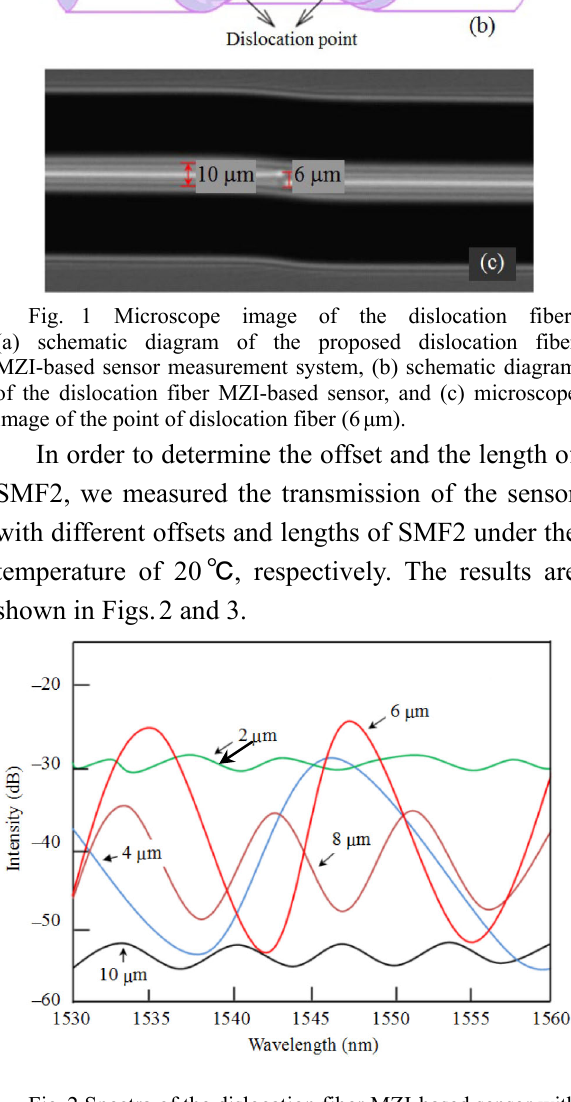
Fig. 2 Spectra of the dislocation fiber MZI-based sensor with offsets of 2 μm , 4 μm, 8 μm, 10 μm , and a SMF2 length of 6 mm,